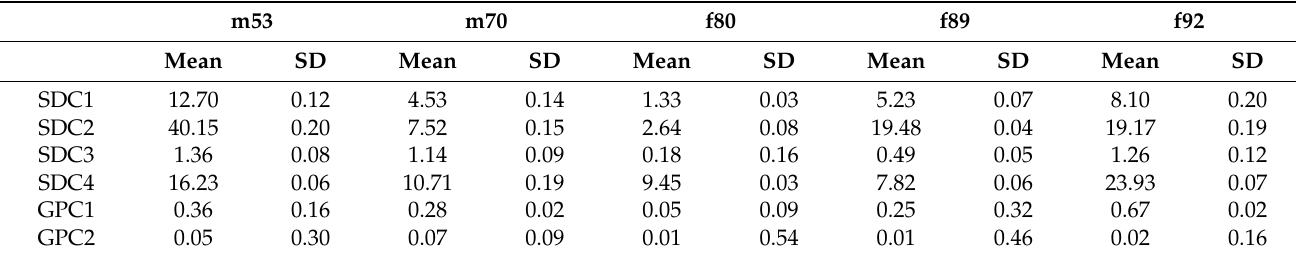
Figure 1. Expression profile of various genes in human lung tissues determined by RT-qPCR. Relative patient-specific mRNA expression levels of relevant syndecans (SDC) 1,2,4; glypicans (GPC) 3,4,5; sulfatases (SULF) 1,2; O-sulfotransferases (OST) 2OST, 3OST-1, 3 OST-3b; and N-sulfotransferase (NDST) 1,2. mRNA of five different donors are depicted in relation to the housekeeping gene glycerinaldehyd-3-phosphat-dehydrogenase (GAPDH) as mean ± SD with n = 3. Table 1. Relative gene expression profile (% GAPDH) of different HS isolates from human lung in relation to GAPDH expression. Relative patient-specific mRNA expression levels of syndecans (SDC) 1,2,3,4; glypicans (GPC) 1,2 3,4,5; sulfatase (SULF) 1,2; O-sulfotransferases (OST) 2OST, 3OST-1,3OST-2, 3OST-3A1, 3OST3b, 3OST 4–6, 6OST 1–3; heparanase (HPSE); and N-sulfotransferase (NDST) 1–4. mRNA of five different donors are depicted in relation to the housekeeping gene GAPDH as mean ± SD with n =